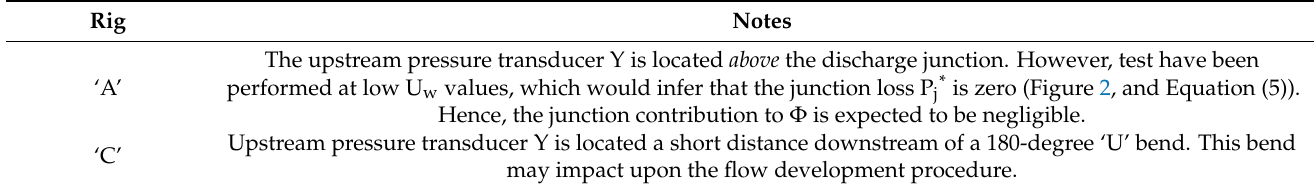
Table 2. Notes which apply to calculation of the Φ d components shown in Figure 8 using the Rig ‘A’ and Rig ‘C’ datasets. Rig